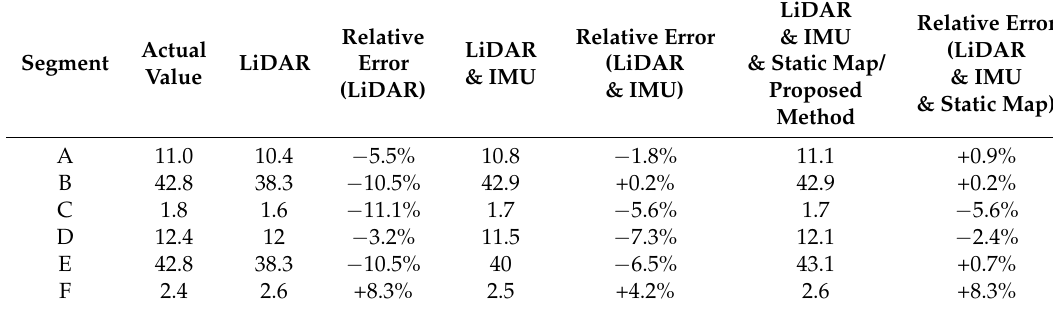
Table 2. Error Comparison in Closed